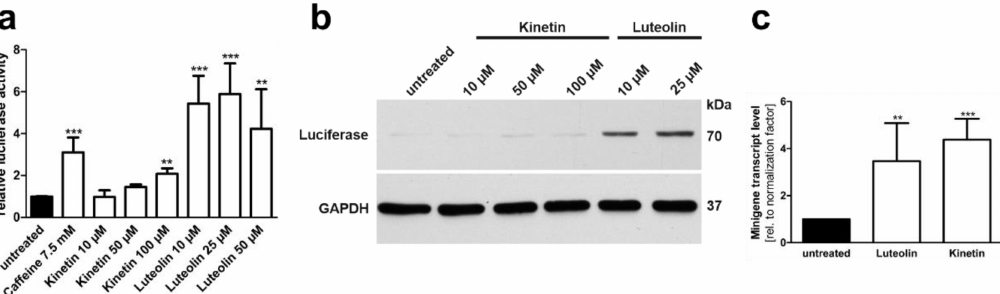
Figure 9. Minigene splicing assays in HEK293T cells: Effect of luteolin and kinetin. ( a ) AGA knockout HEK293T cells were transfected with the minigene-luciferase construct and treated with increasing amounts of substances for 24 h. Relative luciferase activity of the untreated samples was set as 1. Bars represent the mean ± SD of at least three independent experiments, one-way ANOVA against the untreated samples. ( b ) Protein lysates from ( a ) were analysed by SDS-PAGE and Western blot. Luciferase expression corresponds to the luciferase activity shown in ( a ). ( c ) AGA knockout HEK293T cells were transfected with the AGA minigene construct without luciferase and treated with 25 µ M luteolin or 50 µ M kinetin for 24 h. Total RNA was isolated, reversely transcribed and analyzed by qRT-PCR. Bars represent the mean ± SD of six independent experiments, one-way ANOVA against the untreated samples. Values of p < 0.01 were considered very significant (**) and p < 0.001 extremely significant